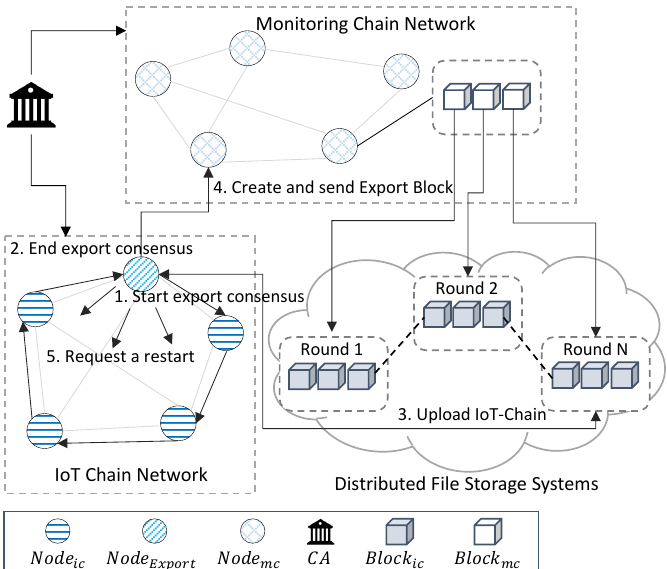
Figure 7. The export process between Network ic and Network mc : ( 1 ) Node export maintains the routing table and agrees to verify that the BH last of all nodes is the same. ( 2 ) The combined signature of all nodes is sent to Node export , and Key pub of Node ic is requested from CA to generate and verify Key schnorr . ( 3 ) IC is saved in the DFS and Address ic is returned. ( 4 ) Block export , including Address ic , Key schnorr , and Sig schnorr , is transferred to Network mc and saved. ( 5 ) All Node ic of Network ic restart the IC starting with Block genesis with PreviousHash of BH last of IC embedded in MC